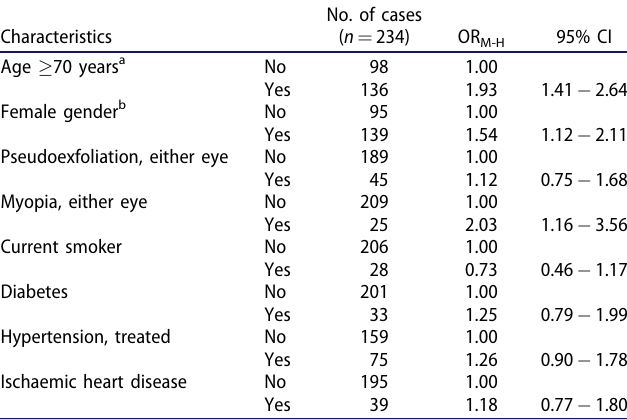
Table 4. Odds ratios for cataract in the population survey in Tierp, adjusted for age and gender.